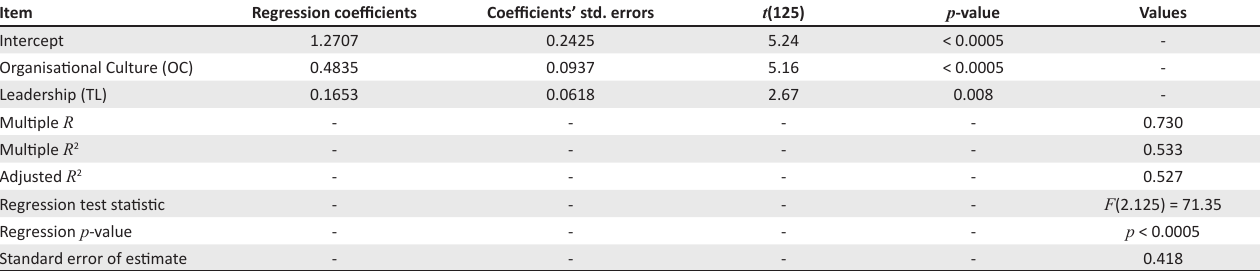
TABLE 6: Multiple linear regression analysis results. Item Regression coefficients Coefficients’ std.